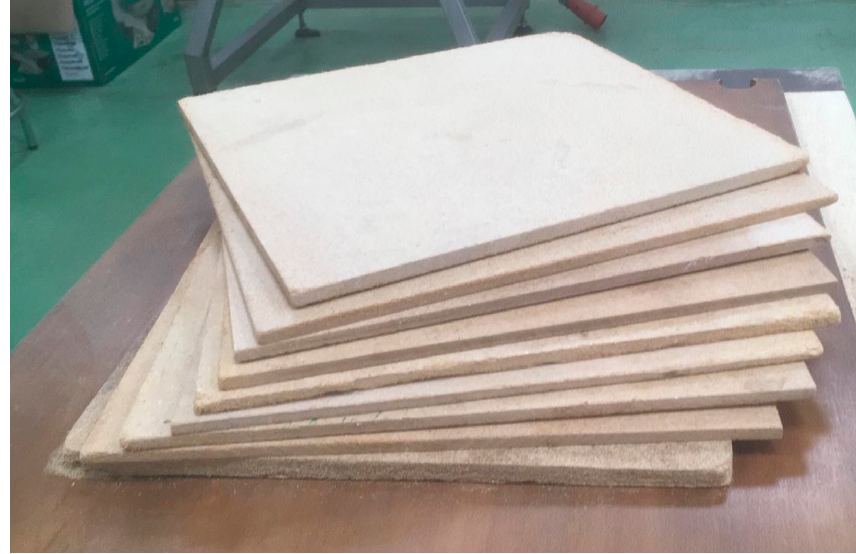
Figure 4. Samples of the experimental particleboards.